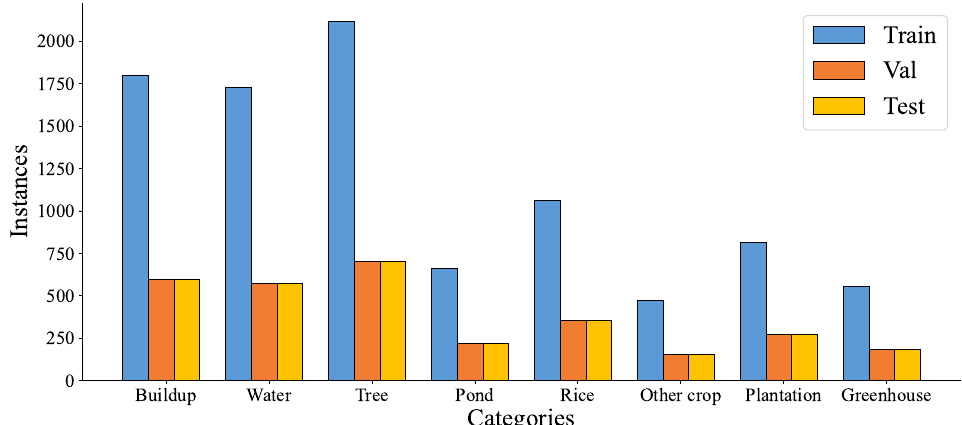
Figure 2. Class-label instances for Changxing County sample bank.